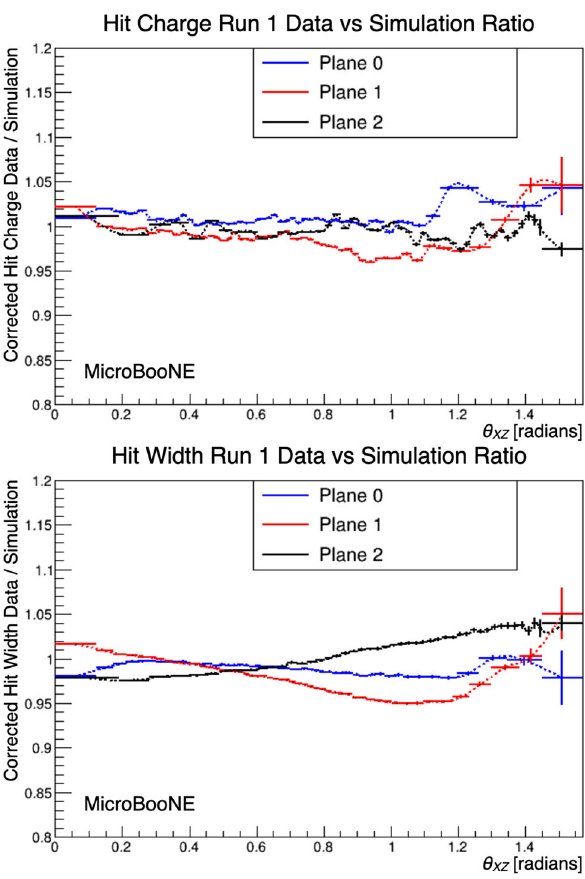
Fig. 8 Ratio functions (data/simulation) for hit charge (top) and hit width (bottom) vs. θ XZ . The solid lines are the values of the ratio in each bin, and the dashed lines are the spline fits. The bins at 1 . 4 < θ < π/ 2 rad are extrapolated as described in the text XZ